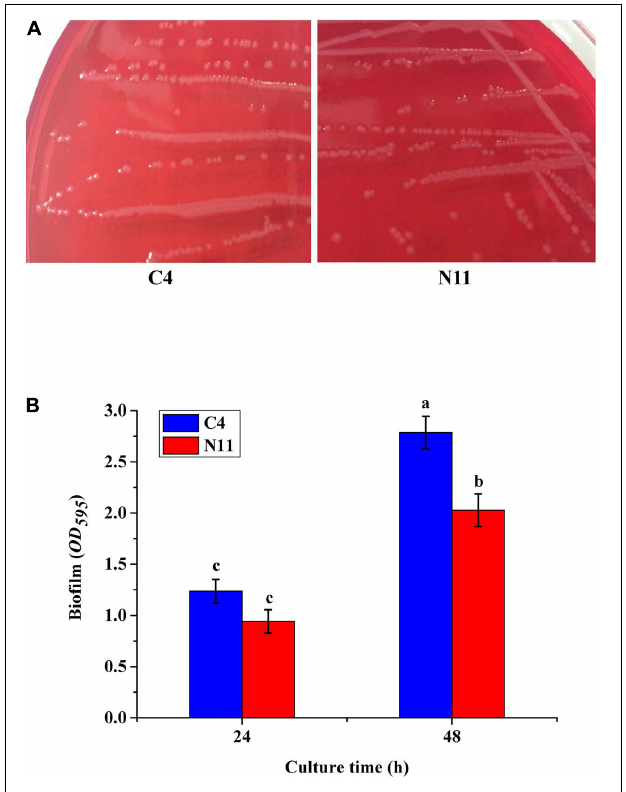
FIGURE 4 | In vitro virulence test results of the C4 and N11 strains. (A) Kanagawa phenomenon. (B) Biofilms formed by different strains after culture for 24 and 48